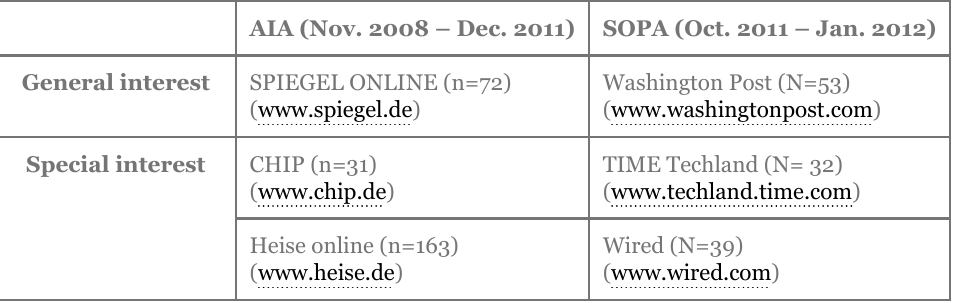
Table 1: Selected articles and